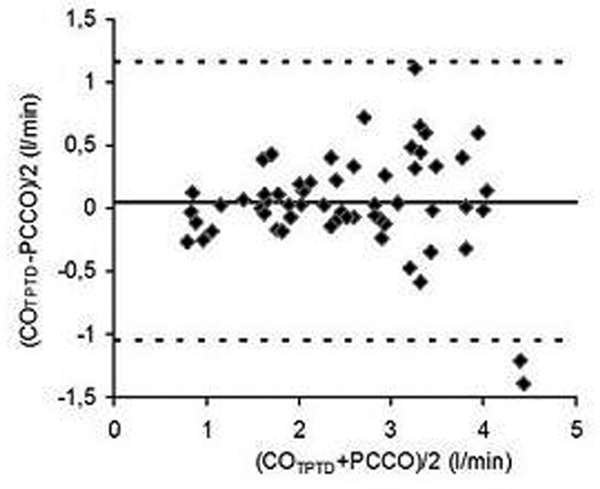
Bland-Altman analysis of COTPTD and PCCO.